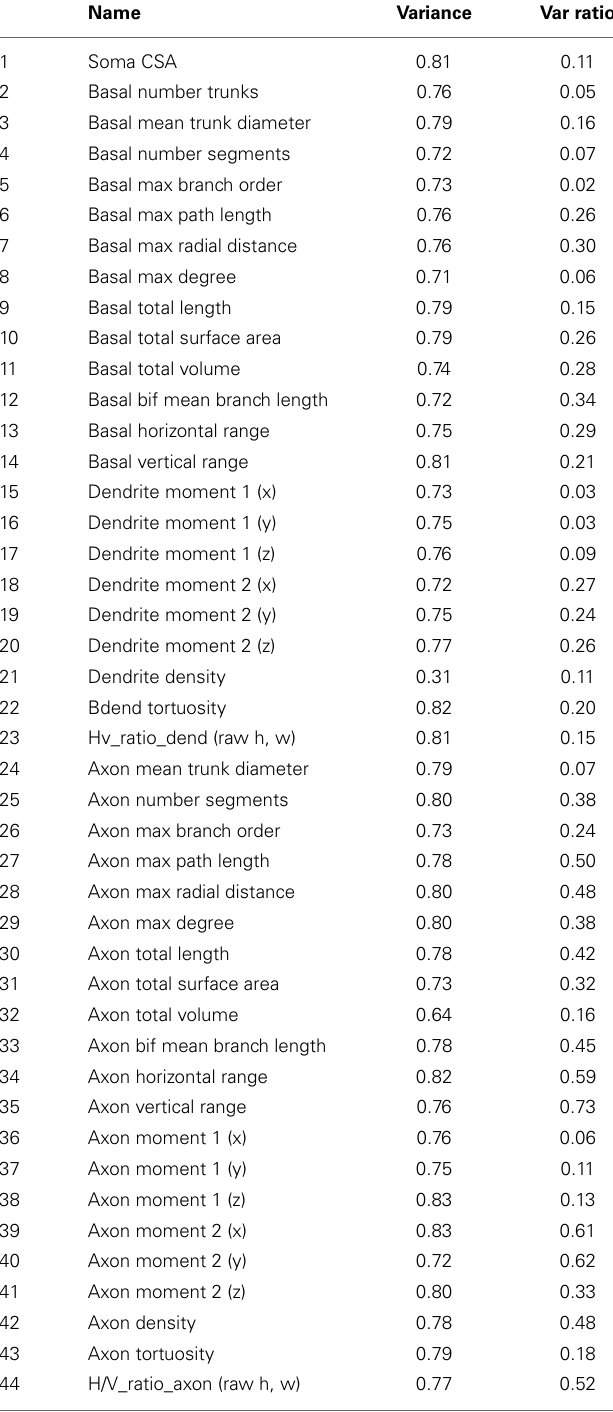
Table 2 | A listing of all the morphometric features used for the objective analyses with PCA and LDA.